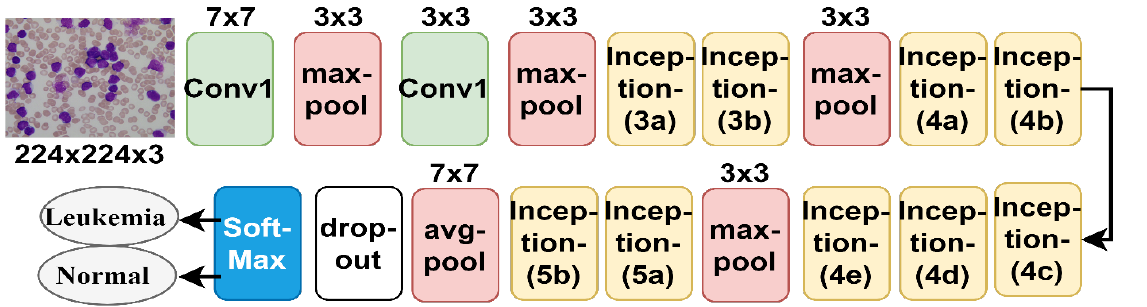
Figure 9. GoogLeNet network structure for ALL-IDB dataset diagnostics.